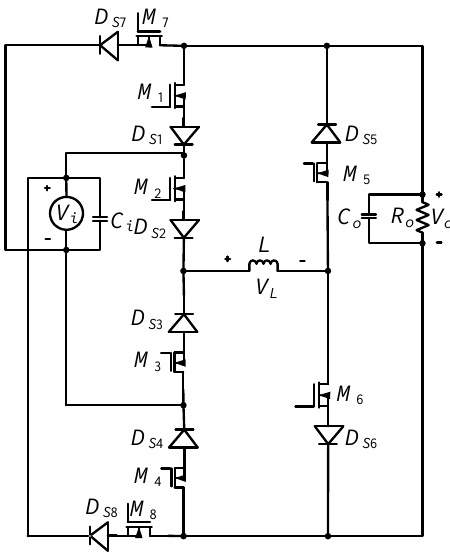
Figure 1. Proposed circuit topology.